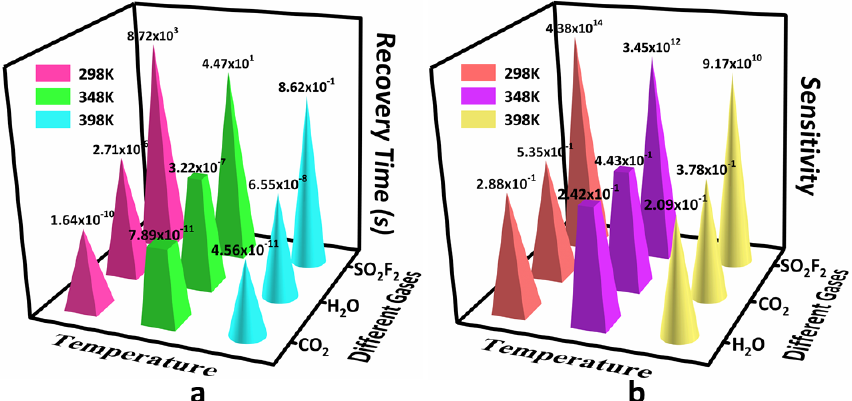
Figure 4. The ( a ) recovery time and ( b ) sensitivity of three adsorption systems.